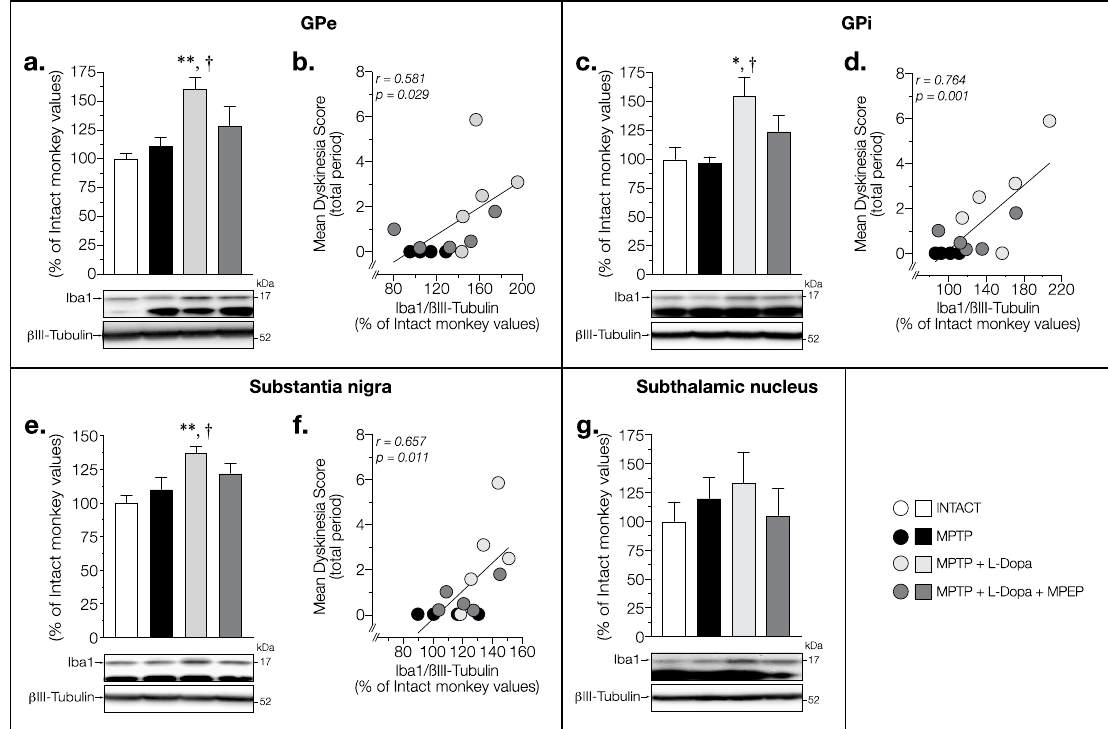
Figure 7. Western blots for Iba1 protein levels in ( a ) GPe, ( c ) GPi, ( e ) substantia nigra, and ( g ) subthalamic nucleus of intact monkeys (control), MPTP monkeys treated with saline, L-Dopa, and L-Dopa + MPEP, and correlation between mean dyskinesia score of MPTP monkeys treated with saline, L-Dopa, and L-Dopa + MPEP, and Iba1 levels in the ( b ) GPe, ( d ) GPi, and ( f ) substantia nigra expressed as percentage of control (βIII -tubulin was used as internal loading control); each point represents an individual monkey. Values are means of arbitrary units expressed as percentage of control (βIII -tubulin was used as internal loading control) of 2 – 4 independent experiments ± standard error of mean of 4 – 5 monkeys per group. * p < 0.05 and ** p < 0.01 vs. INTACT; † p < 0.05 vs. MPTP.